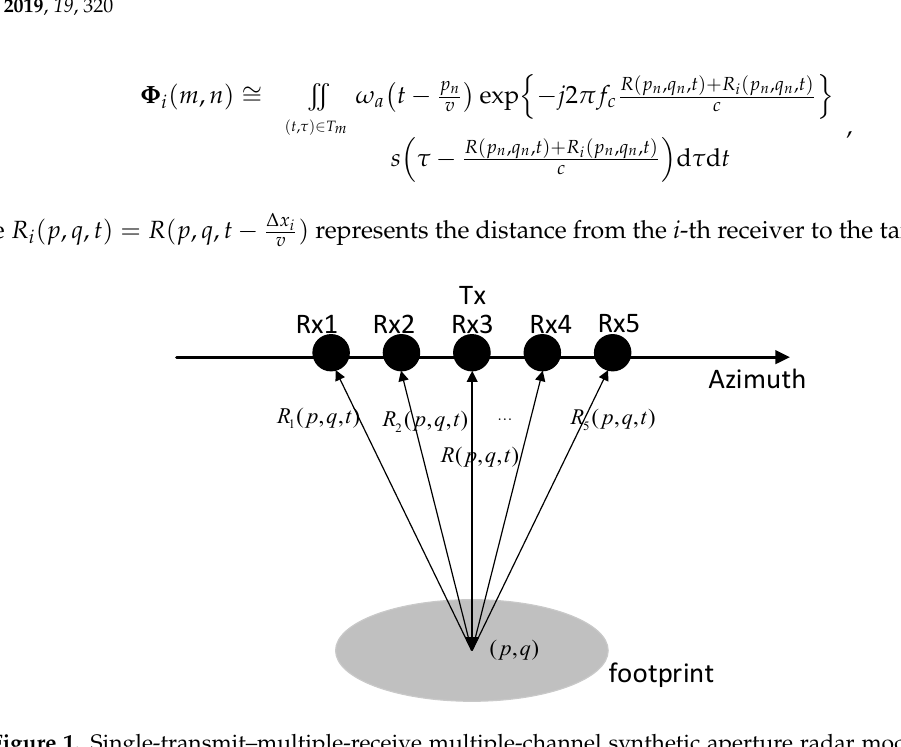
Figure 1. Single-transmit–multiple-receive multiple-channel synthetic aperture radar mode. Black circles correspond to transmitter (Tx) and receiver (Rx) positions.